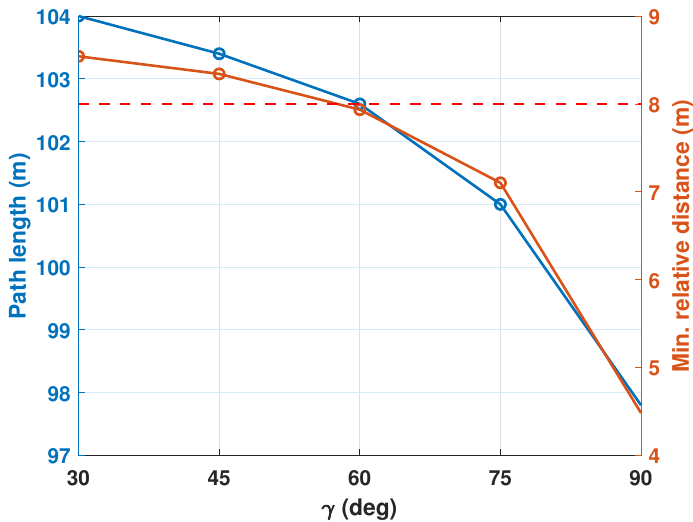
Figure 5. Path length and minimum relative distance in accordance with γ .